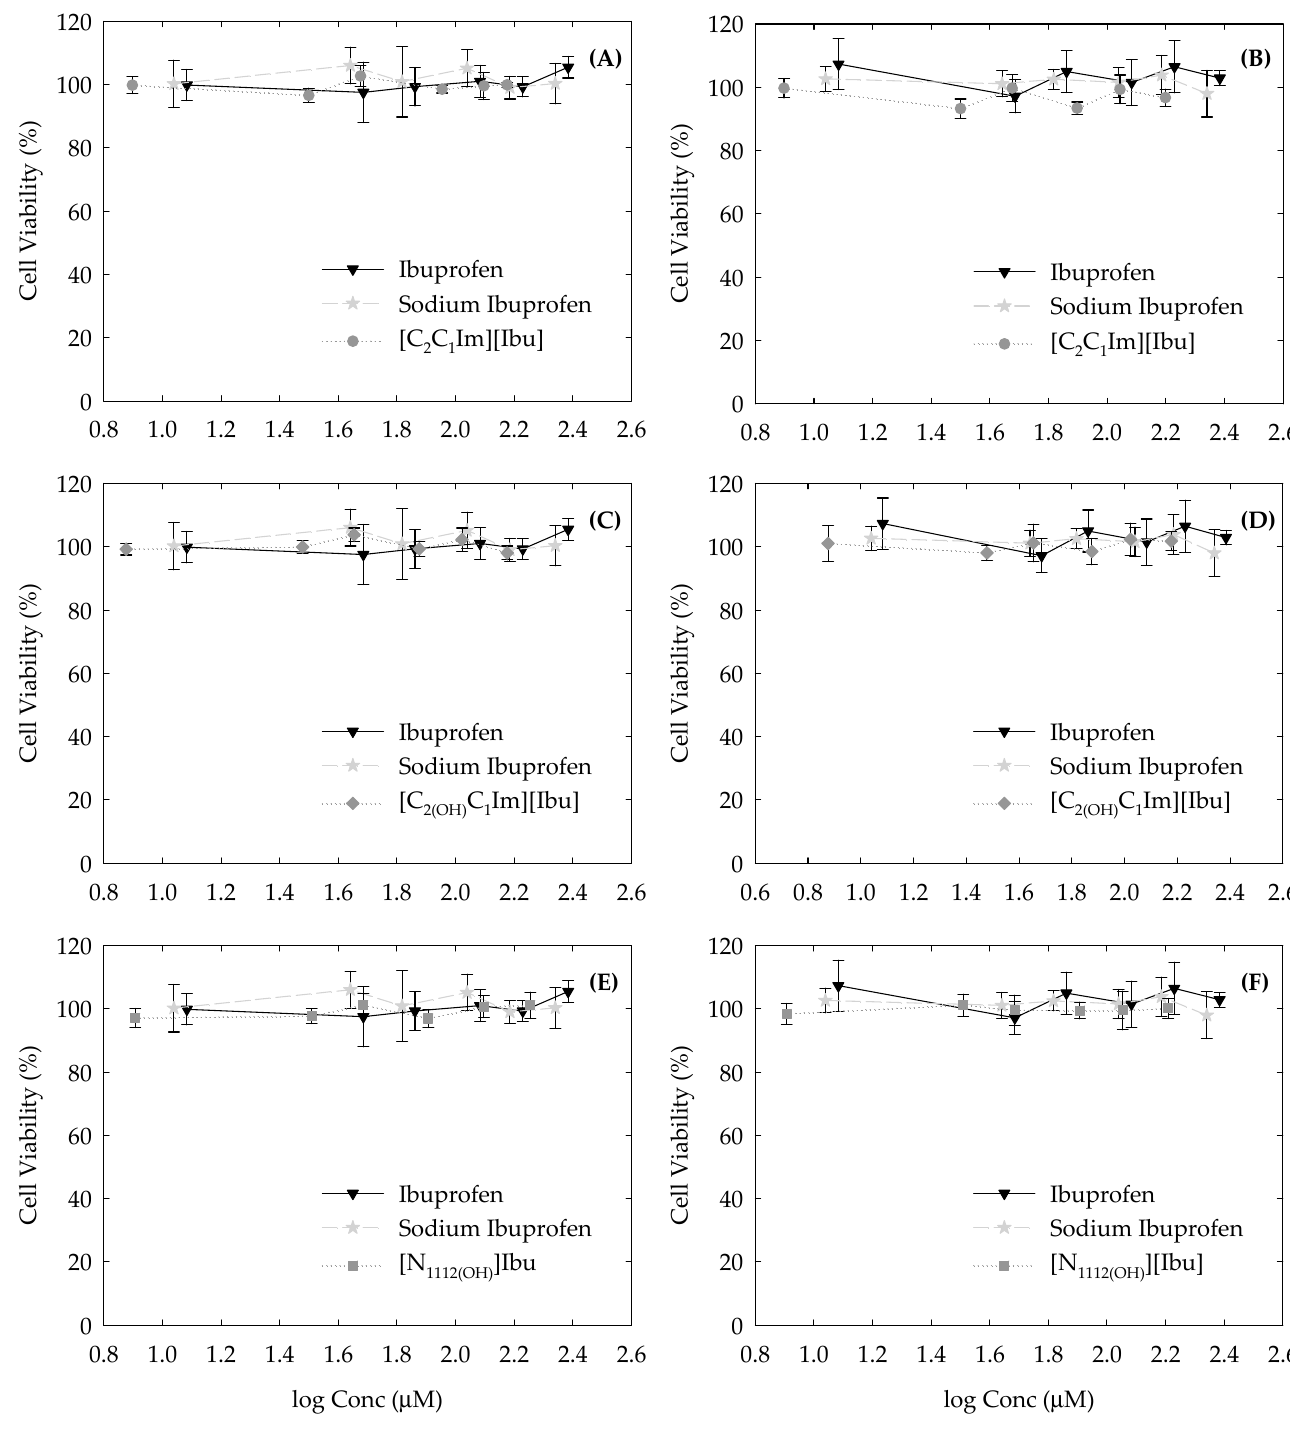
Figure 2. Cytotoxicity profiles of ibuprofen in the neutral and sodium salt forms compared with [C 2 C 1 Im][Ibu] in Caco-2 ( A ) and HepG2 ( B ) with [C 2(OH) C 1 Im][Ibu] in Caco-2 ( C ) and HepG2 ( D ) and with [N 1112(OH) ][Ibu] in Caco-2 ( E ) and HepG2 ( F ). Both Caco-2 and HepG2 cells were exposed for 24 h to the respective API-ILs and parent API at the concentrations